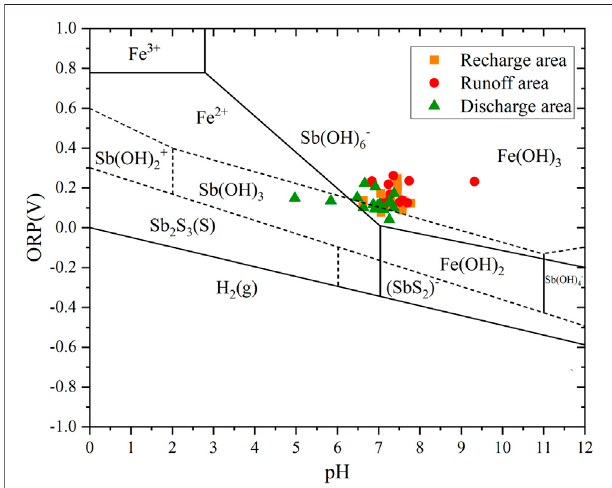
FIGURE 7 | Relationship between pH and ORP for all shallow groundwater samples.